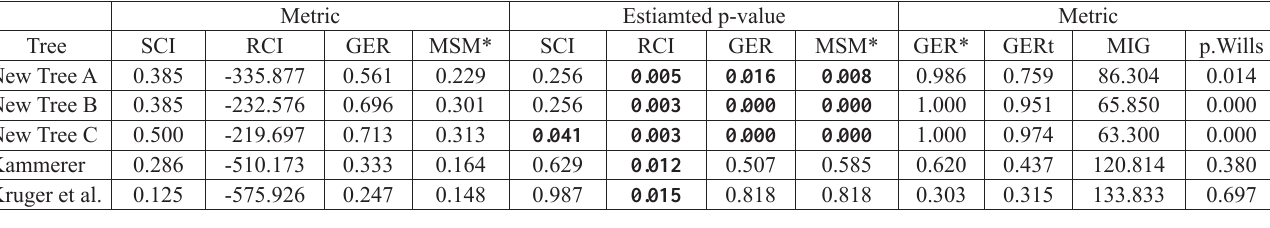
→ Fig. 6. Three new phylogenies for Biarmosuchia scaled to time and plotted against Permian Beaufort biostratigraphy. A . Single most parsimonious tree calculated using implied weights (k  4) and when Biarmosuchus is used as the outgroup. B . Single most parsimonious tree calculated using implied weights (k = 5–7) and when Biarmosuchus is used as the outgroup. C . Strict-consensus of the two shortest trees recovered using equal weights and when Hipposaurus was used as the outgroup. A is the least congruent of the twelve trees calculated from the new dataset and is the only one in which Bullacephalus and Pachydectes are nested within Burnetiamorpha and in which the Ichtidorhinidae is not monophyletic. Numbers at nodes indicate symmetric resampling values based on 10 000 replicates with a cutoff of 50; dotted line indicates the Capitanian extinction horizon as recorded in South Africa; dashed lines indicate cladogenic events that could have occurred after this horizon.